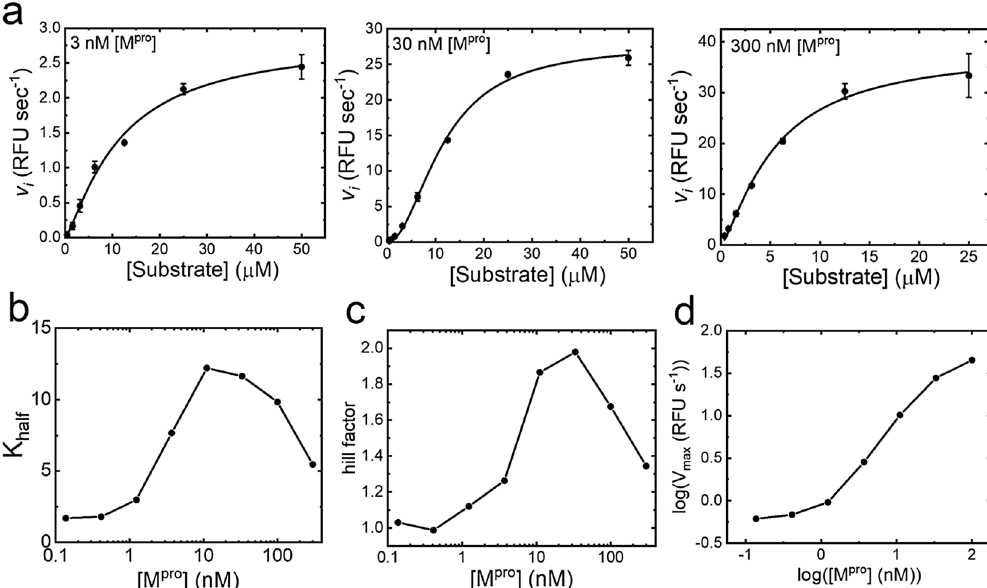
Figure 1. M pro enzymology. Panel ( a ) shows the initial rate of substrate cleavage by M pro at different enzyme concentrations. Data are plotted as an average of four replicates, shown as black circles with error bars representing the standard deviation; a fit of an allosteric sigmoidal model is shown as a black line. Panels ( b ) and ( c ) show a bell-shaped relationship for both the Hill-factor and K half obtained for M pro -substrate kinetics at differing concentrations of M pro , fitted results are shown as black circles, with lines between the points. Panel ( d ) shows a log–log plot of [M pro ] vs V max ; circles show the fitted results.